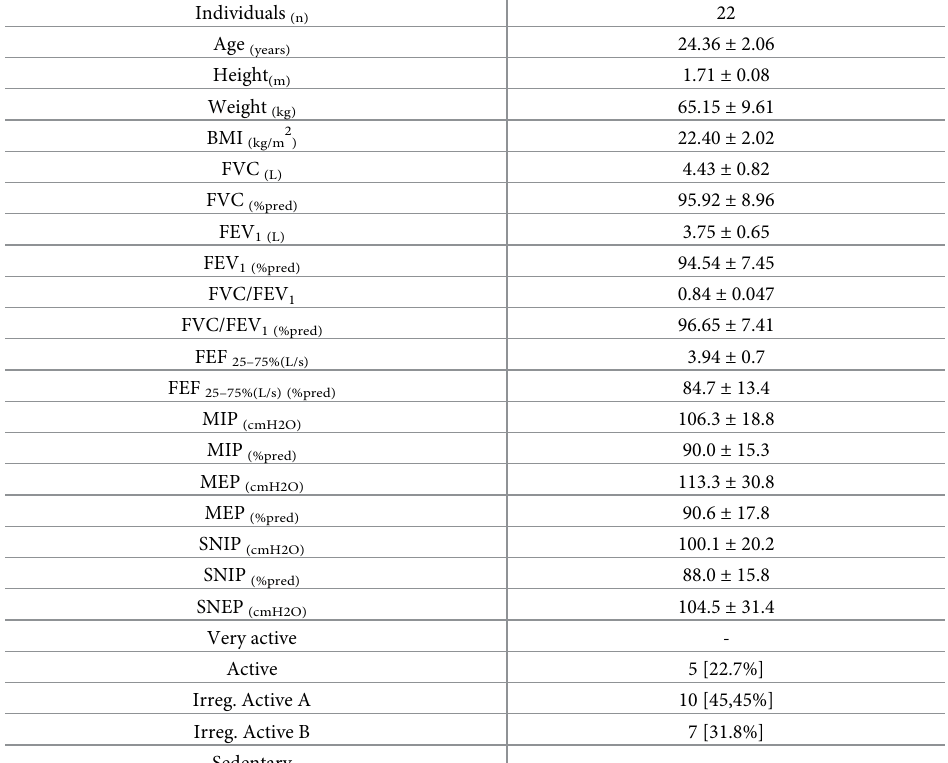
Table 1. Anthropometric data, absolute and predicted values of lung function, respiratory muscle strength, and physical activity level. Individuals